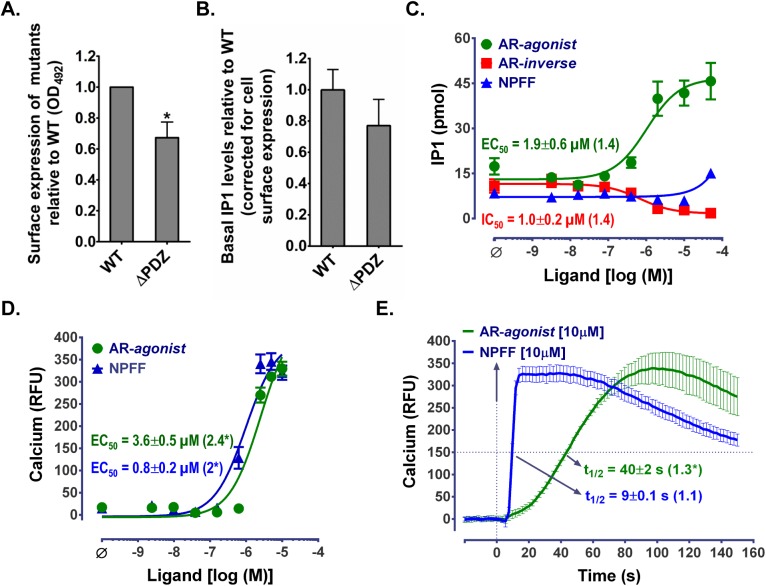
Summary of ΔPDZ-MAS expression and signaling compared to WT.
(A) Surface expression of ΔPDZ-MAS to WT evaluated using enzyme linked immunosorbent assay (ELISA). (B) The bar graph showing the constitutive/basal IP1 levels (in the absence of any ligand treatment) in ΔPDZ-MAS relative to the WT after normalizing for cell surface expression. The ligand dose-responses of ΔPDZ-MAS in (C) IP1 and (D) calcium functional assays compared to WT. (E) The calcium flux kinetics (t1/2) upon treatment with NPFF and AR-agonist compared to WT. The EC50 or IC50 values are also shown in panels C and D while t1/2 values are shown in panel E. The relative EC50, IC50 and t1/2 values as compared to WT (fold increase) are shown in parentheses. Data for WT and the experimental methodology for ELISA, IP1 and calcium functional assays have been reported previously [23]; Values are mean±SEM from at least two independent experiments; Statistical significance (t-test)—*p<0.05.